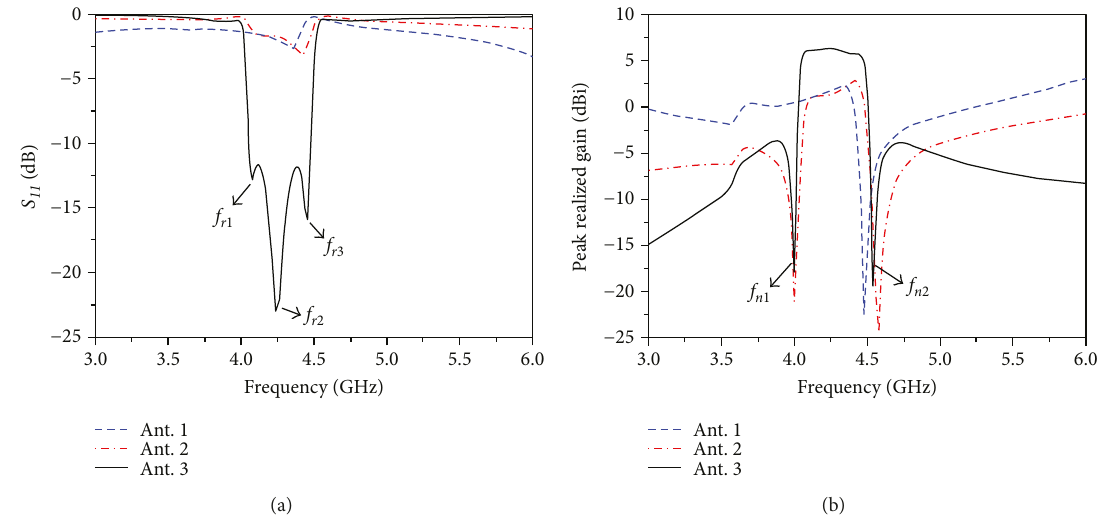
Figure 3: Simulated results of Ant. 1, Ant. 2, and Ant. 3. (a) Re fl ection coe ffi cient S